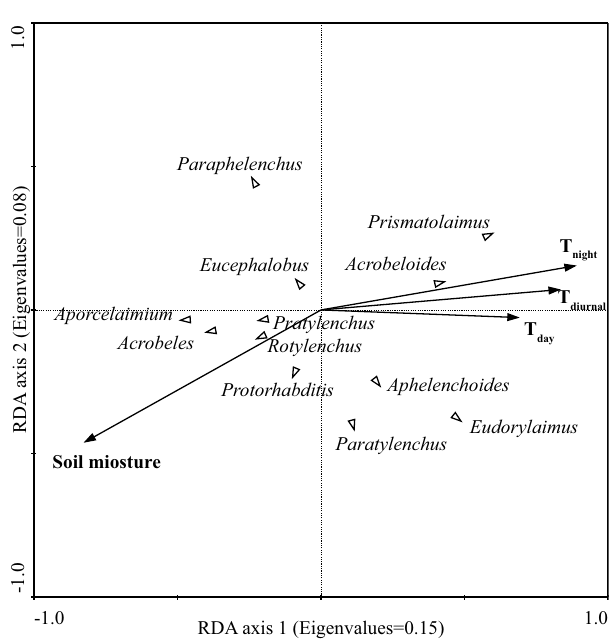
-1.0 Figure 2. RDA bi-plot of nematode genus and environmental variables. T night is average temperature in night-time. T day is average temperature in daytime. T diurnal is daily (24 hour) average temperature. The species- environment correlations were 0.76 for axis 1 and 0.74 for axis 2. The environmental variables explained 27.9% of the total variance in the species data (Soil moisture: 14.6%, p = 0.002; T night : 14.4%, p = 0.002; T diurnal : 13.3%, p = 0.004; T day : 11.2%, p =